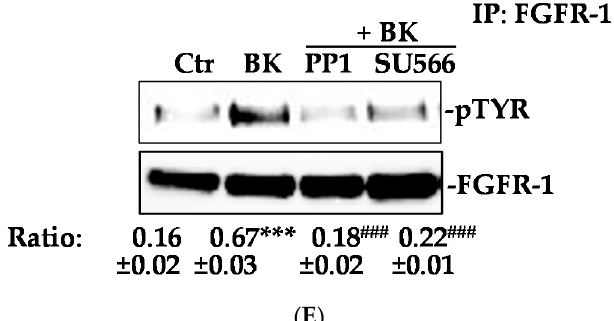
Figure 5. c-Src mediates FGFR-1 phosphorylation induced by BK/B2R system. ( A ) HUVEC and ( B ) HREC were treated with fasitibant (fas, 1 µM), then stimulated with BK (1 µM) for 15 min, and c-SRC phosphorylation was measured using western blot analysis. Results were normalized to SRC. FRS α phosphorylation was measured using western blot analysis in ( C ) HUVEC and ( D ) HREC treated with PP1 (500 nM), or SU566 (10 µM) (Src inhibitors) for 30 min, and then stimulated with BK (1 µM) for 15 min. Results were normalized to FRS α . ( E ) HUVEC were treated with PP1 (500 nM), or SU566 (10 µM) as above, and then stimulated with BK (1 µM) for 10 min. FGFR-1 was immunoprecipitated